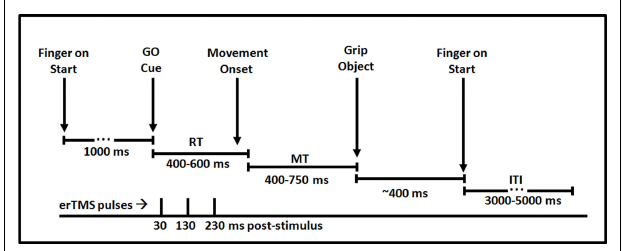
FIGURE 2 | Time course of a single trial in the current experiment. Participants began with their fi nger on a centrally located start button. Following presentation of a critical go-cue (biological or non-biological), participants prepared and executed the appropriate movement. TMS pulses were delivered 30, 130 and 230 ms post-stimulus. After gripping the manipulandum participants returned their fi nger to the start button and awaited presentation of the subsequent